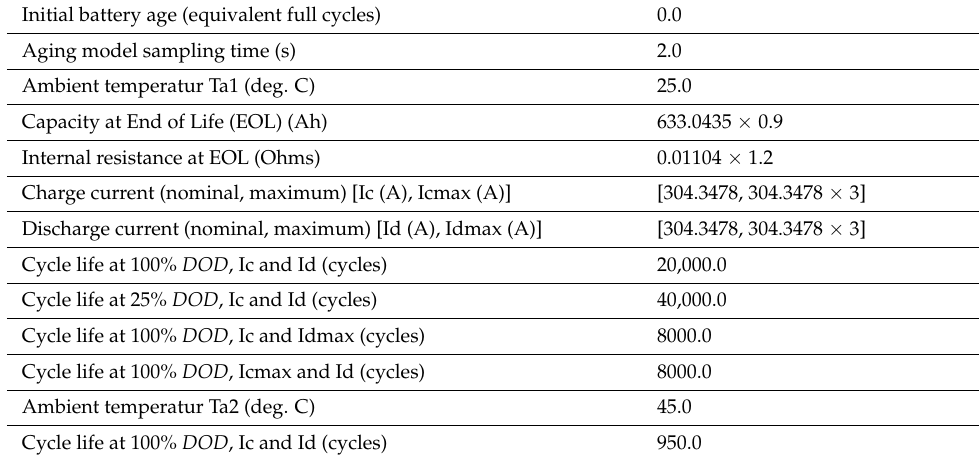
Table 5. Parameters for battery